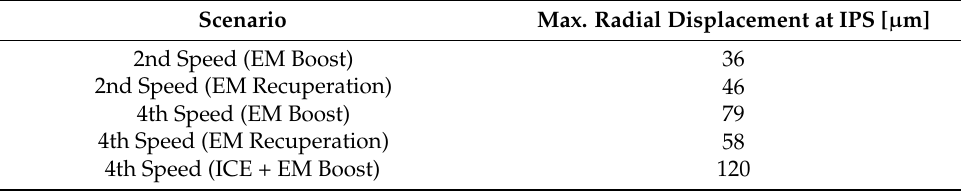
Figure 7. ( a ) Mesh used for the FEM analysis: ( b ) zoom view; ( c ) convergence plot. Table 2. The displacement results